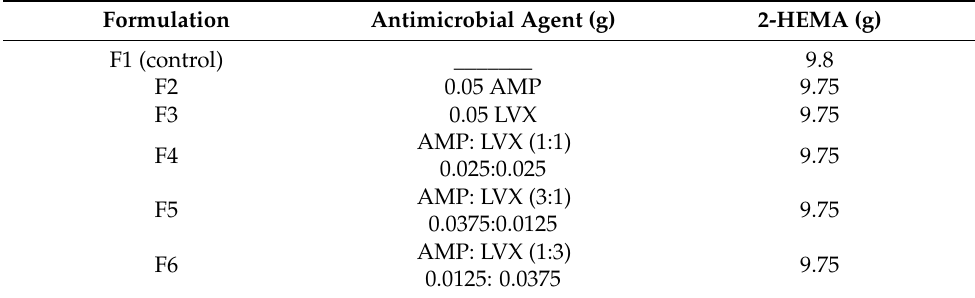
Table 1. Formulations, components and ratios of the prepared hydrogel